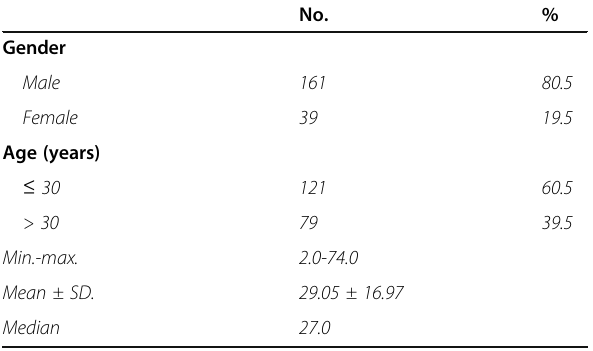
Table 1 The demographic data of the patients included in the